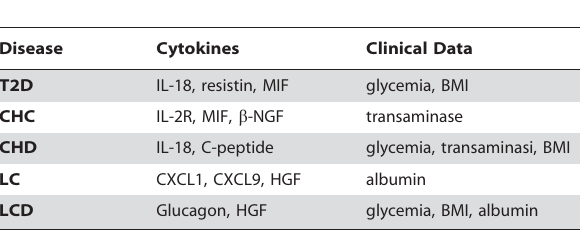
Table 3. Significant correlations between cytokines and clinical/biochemical data in all